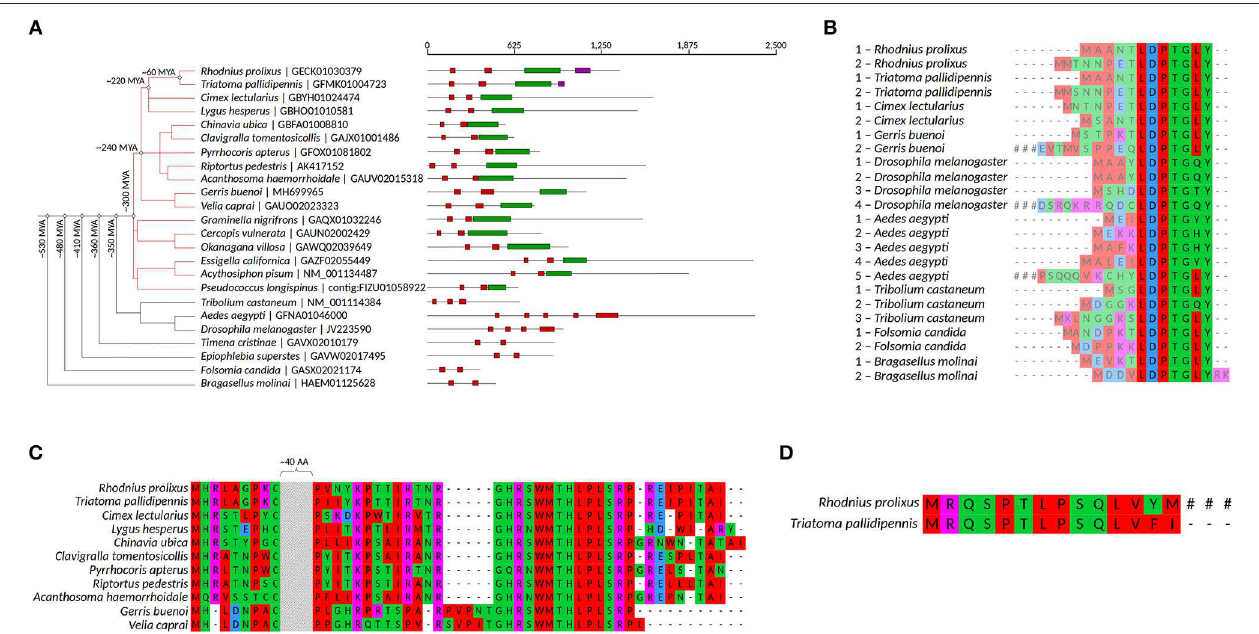
FIGURE 1 | mlpt evolutionary analysis and putative regulation. (A) Phylogenetic representation of mlpt distribution among arthropod species and approximate time of node speciation based on the online server TimeTree ( Kumar et al., 2017). mlpt polycistronic mRNA organization. Black lines comprise the whole polycistronic mRNA containing the smORFs encoding peptides displayed in red, green, and pink boxes. (B) Alignment of the previously described small peptide (red boxes in A ) containing an LDPTG domain ( Savard et al., 2006; Galindo et al., 2007; Kondo et al., 2007), conserved in several arthropod species and whose number of paralogs in a single polycistronic gene varies among arthropod species. (C) Alignment of a hemipteran specific peptide of about 80 amino acids (green boxes in A ). (D) Alignment of triatomine conserved smORF encoded peptides (pink boxes). # indicates that translation is not interrupted in this